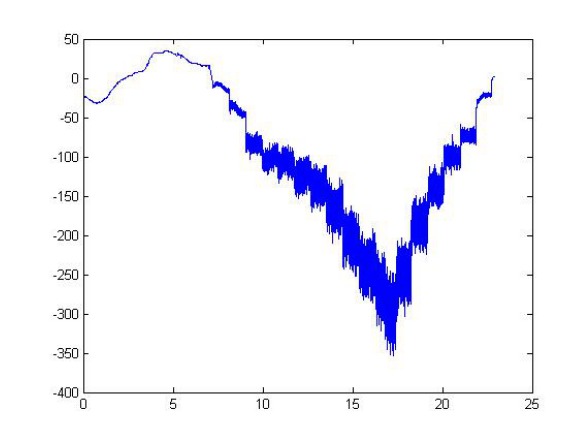
Figure 4: Differential pressure